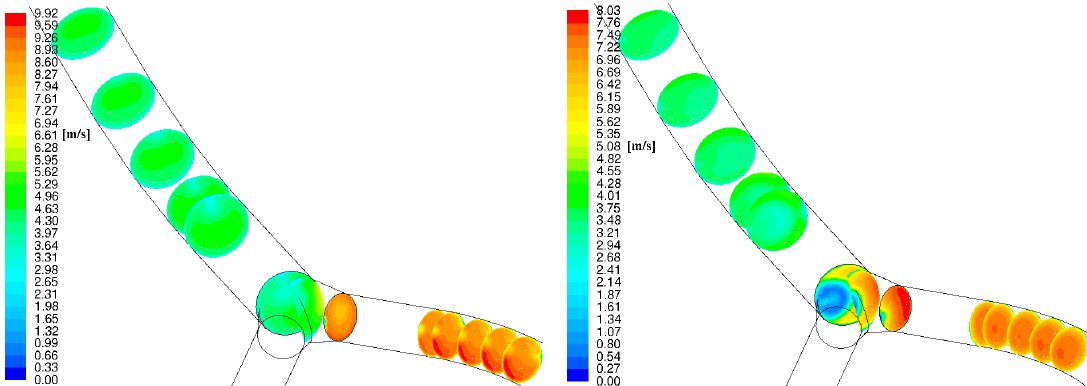
Figure 8. The water velocity contours in the penstock part containing the pipe branch for discharge of Q = 35 m 3 /s in turbine regime ( left view ) and for discharge of Q = 28 m 3 /s in pump regime ( right view ) .